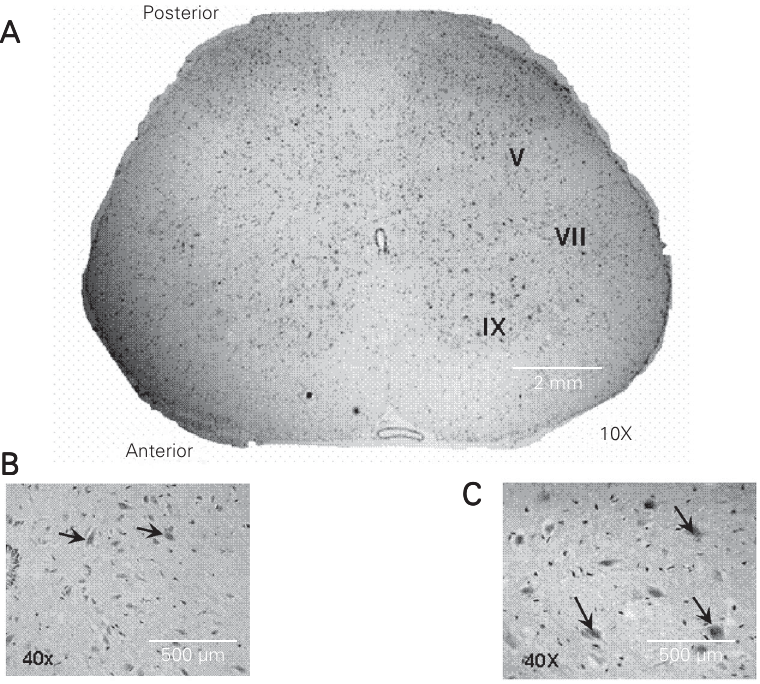
Figure 4. Immunohistochemical reaction of the lumbosacral regions of the spinal cord from a non-human T-lymphotropic virus type I-infected young rat with the monoclonal antibody LT-4 anti-tax. A , General view of motor and sensory areas of the spinal cord that cross- reacted (10X). B , Nuclear cross-reaction observed in some motor neurons of the spinal cord (lamina VII). C , Motor neurons of lamina IX. The arrows indicate a positive immunohis-